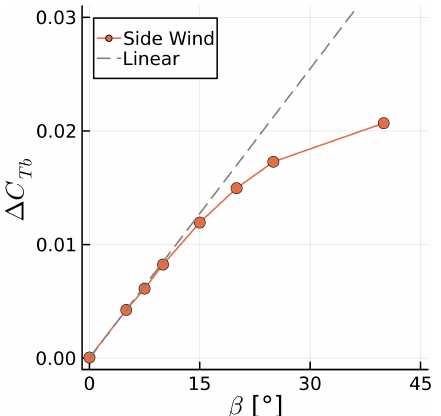
Figure 12. Axial force fluctuation amplitude of single blade during rotation for different side wind angles.